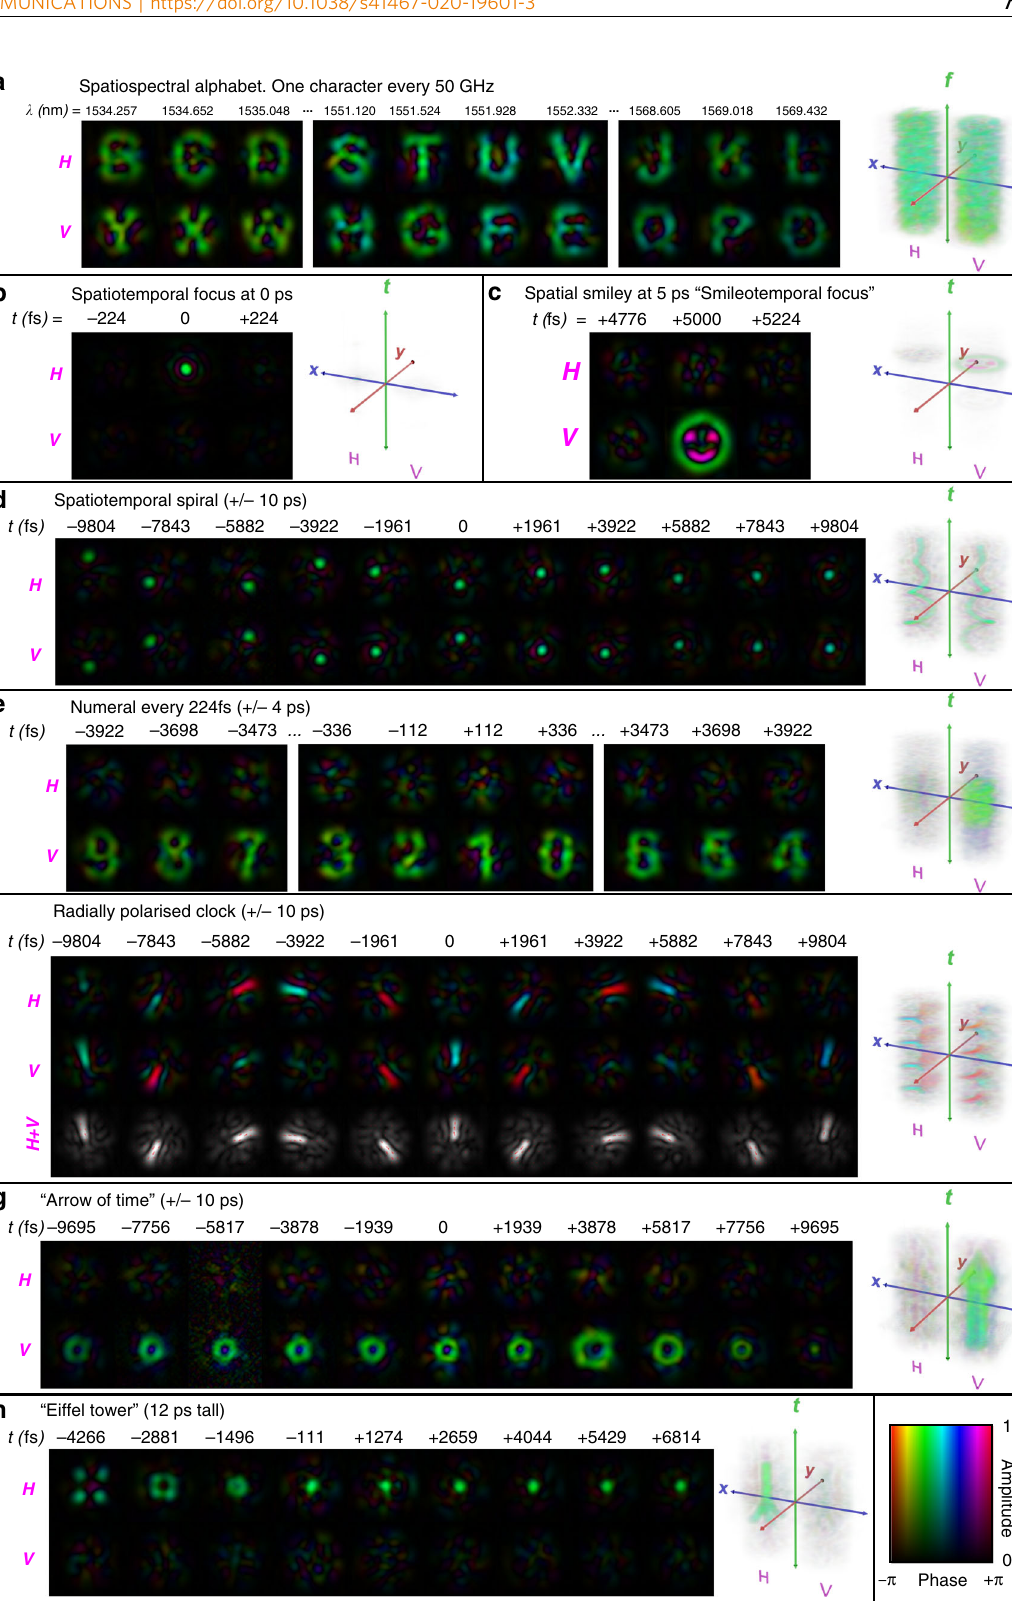
Fig. 3 Selection of vector spatiospectral and spatiotemporal states measured at the distal end of the multimode optical fi bre. Various examples illustrating control of the spatial amplitude, phase and polarisation of a beam as a function of frequency or time. The examples are shown as a sample sequence of measured optical fi elds, as well as a volumetric rendering of the fi eld as function of space, time/frequency and polarisation. a Spatiospectral demonstration. b – h Spatiotemporal demonstrations are Fourier transforms of the measured optical fi elds using swept-wavelength digital holography. Further examples and animations are available in the Supplementary